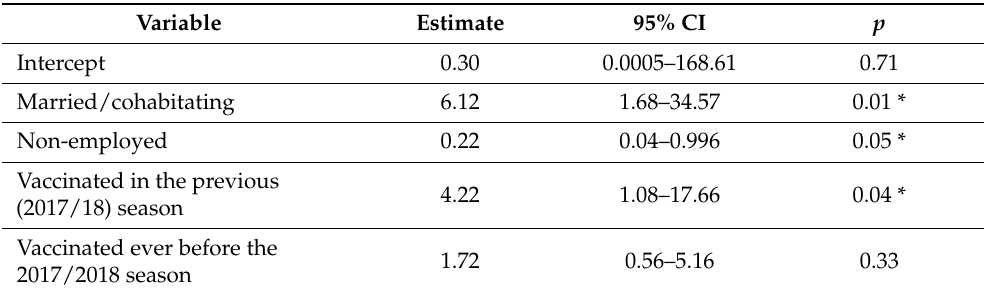
Table 2. Being unemployed was associated with lower odds for vaccination receipt (OR 0.22; p = 0.05). Table 2. Logistic regression model: association of influenza vaccination in the following season with selected variables: estimates, 95% confidence intervals (CIs), and p values; n = 108. Variable Estimate 95% CI p Intercept 0.30 0.0005–168.61 0.71 Married/cohabitating 6.12 1.68–34.57 0.01 * Non-employed 0.22 0.04–0.996 0.05 * Vaccinated in the previous 4.22 1.08–17.66 0.04 * (2017/18) season Vaccinated ever before the 1.72 0.56–5.16 2017/2018 season